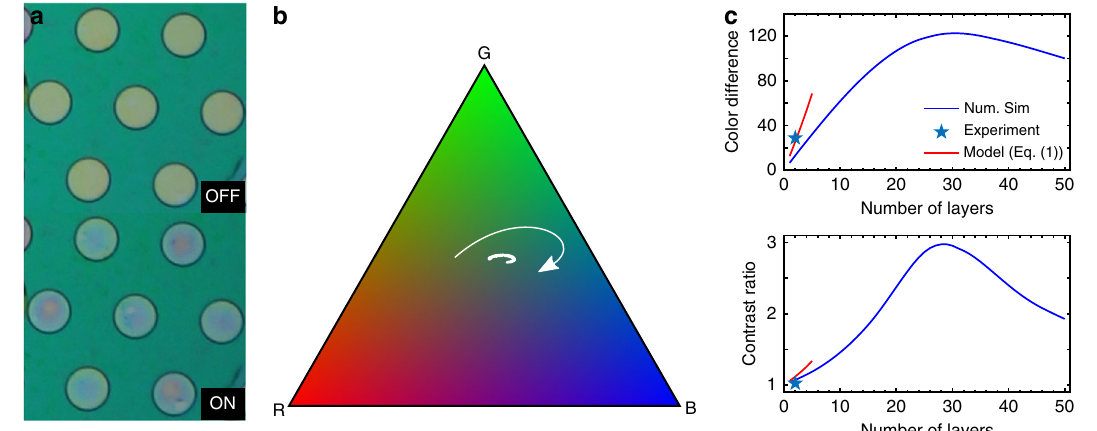
Fig. 4 Graphene Interferometric Modulator Display (GIMOD) prototype. a The graphene mechanical devices are used as continuous-spectrum pixels of 5 μ m in diameter, hence resulting in a re fl ective-type display of 2500 pixels per inch (ppi), equivalent to 12 K + resolution for a display of 5 ″ . When the GIMOD prototype is OFF, its pixels show a yellow color; when it is ON (30 V), they are in a blue state. b Gamut pixel trajectory of the average re fl ectance of a GIMOD prototype with pixels of 5 μ m in diameter. The change of pixel color as a function of voltage, whose direction is pointed with an arrow, is displayed in the sRGB color triangle (subset of x , y chromaticity space) based on CIE1931 colorimetry. c Colorimetric response, given by the parameters contrast ratio (CR, bottom panel) and color difference ( Δ E , top panel), plotted as a function of the number of graphene layers (for a cavity depth of 400 nm) as obtained from the full model simulations described in SI-8. The plots show an optimum of 29 layers, also shown are the results from the analytical model from Eq. (1) (red) and the response obtained experimentally (star symbol) for comparison contrast of about 1:2 due to the large separation between pixels (pixel pitch about double of the pixel size). When the pixels are actuated with 30 V they switch from a yellow state (OFF, top panel) to a blue state (ON, bottom panel). By analyzing the RGB (red, green, and blue) channels of one of the pixels, we obtain its average color gamut and its evolution upon applied voltage. Figure 4b shows the pixel trajectory over a standard RGB (sRGB) color map based on CIE1931 colorime- try 14 , demonstrating the electro-optical modulation from yellow to blue of these pixels.